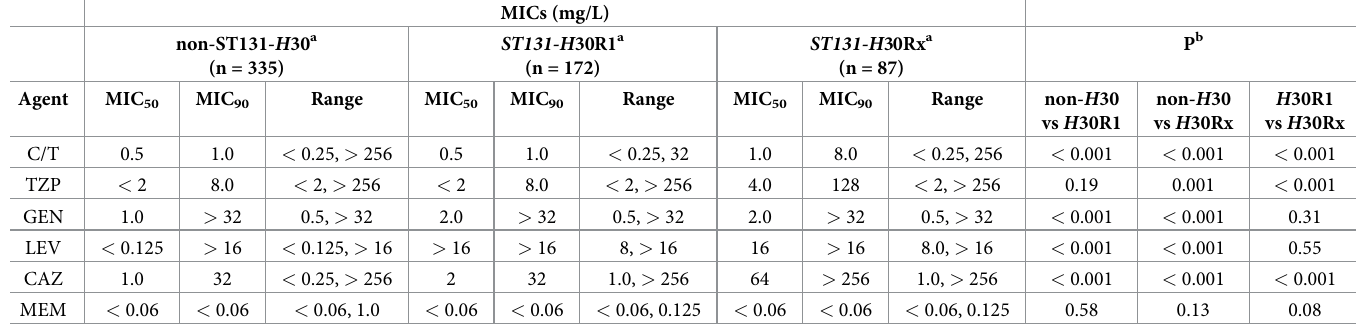
Table 3. MICs for ceftolozane/tazobactam and comparator agents in relation to H 30 subclone status among 594 Escherichia coli clinical isolates from veterans.